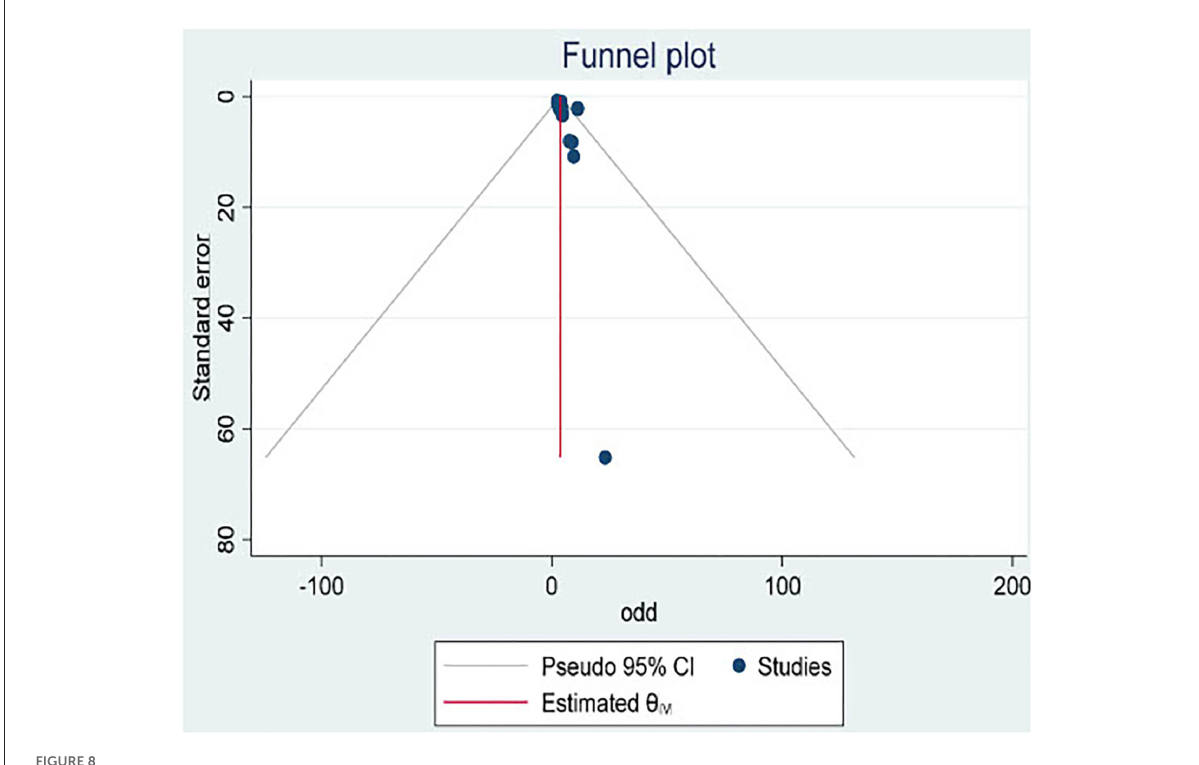
FIGURE8 Perinatal